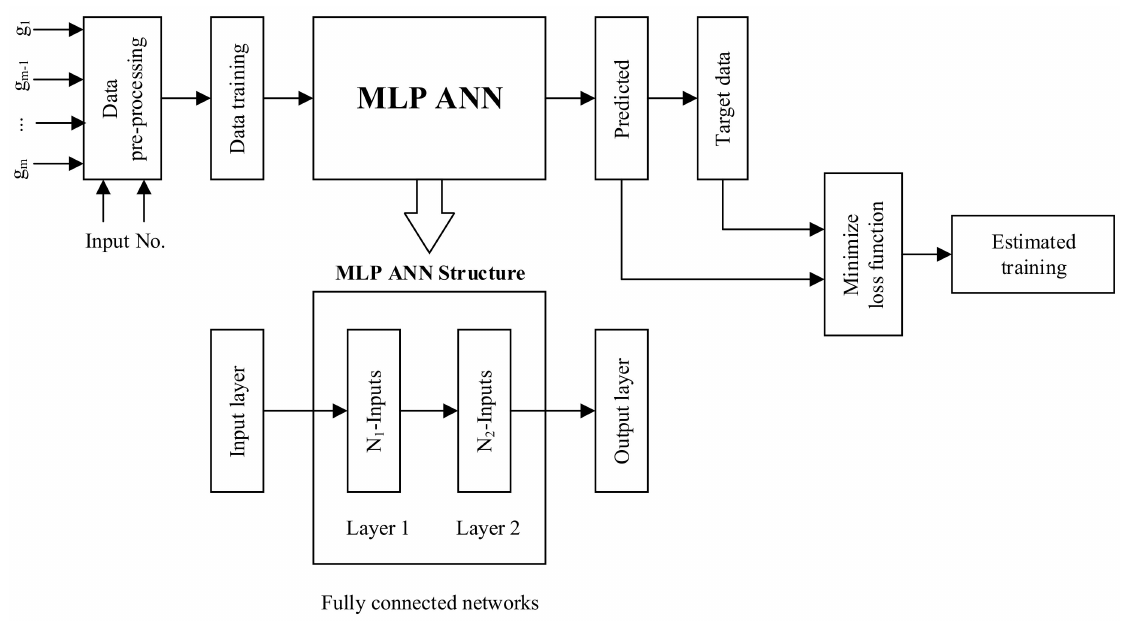
Figure 3. ANN MLP Model Structure for Path Loss